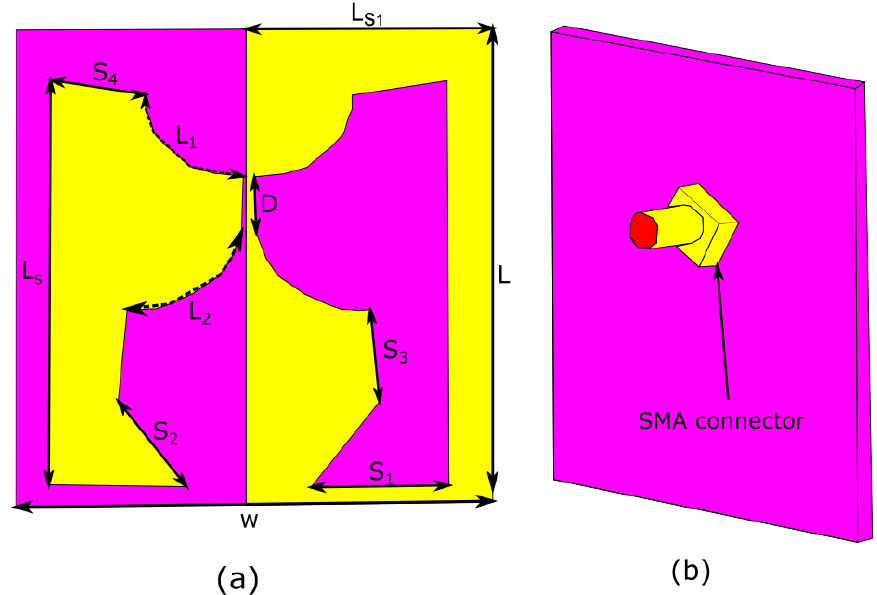
Figure 2. Schematic view of the proposed arc shape self-complementary antenna. ( a ) Top view of the proposed antenna ( b ) Back view of the proposed antenna.